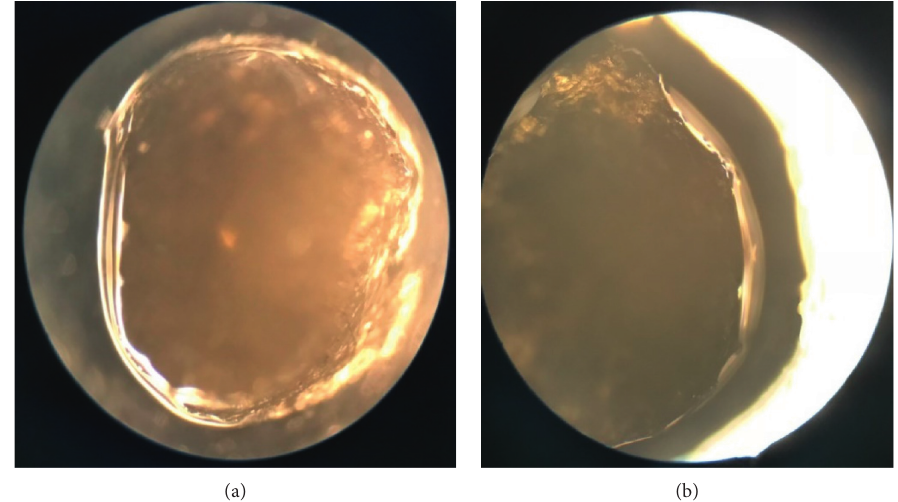
Figure 10: A microbial capsule under an optical microscope: (a) full picture of the microbial capsule; (b) partial view of the microbial capsule.